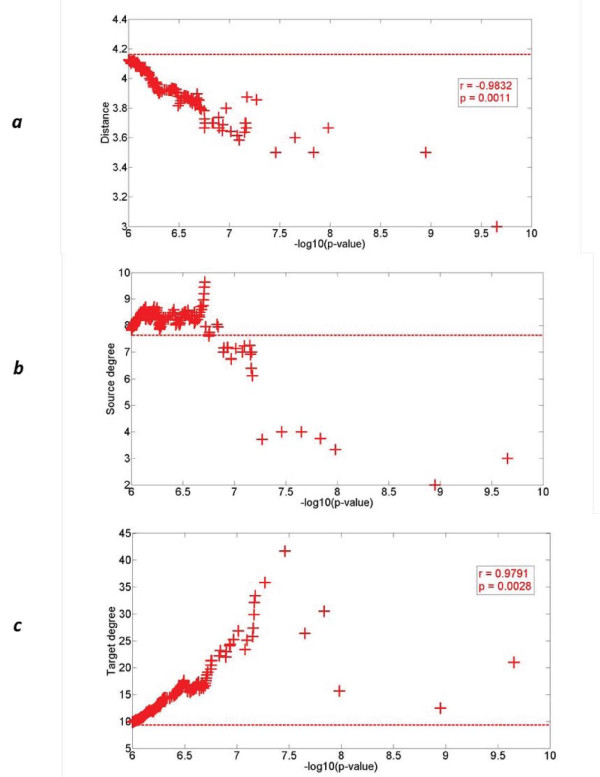
Topological properties on a protein-protein interaction network versus exonic source-target association significance. Averages for (a) distance between source and target, (b) source degree and (c) target degree are evaluated across source-target pairs of candidate exon eSNPs at varying association p-value thresholds (+). The average of randomly permuted pairs (dashed horizontal line) is shown for permuted pairs and Spearman's rank correlation coefficient (denoted r) is listed when significant at P <0.05 (denoted p).